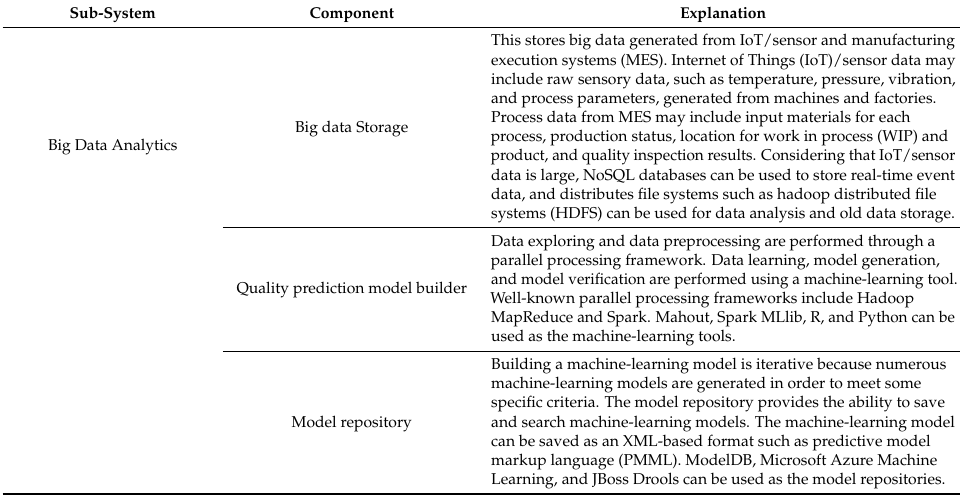
Table 1. CPPS core elements.